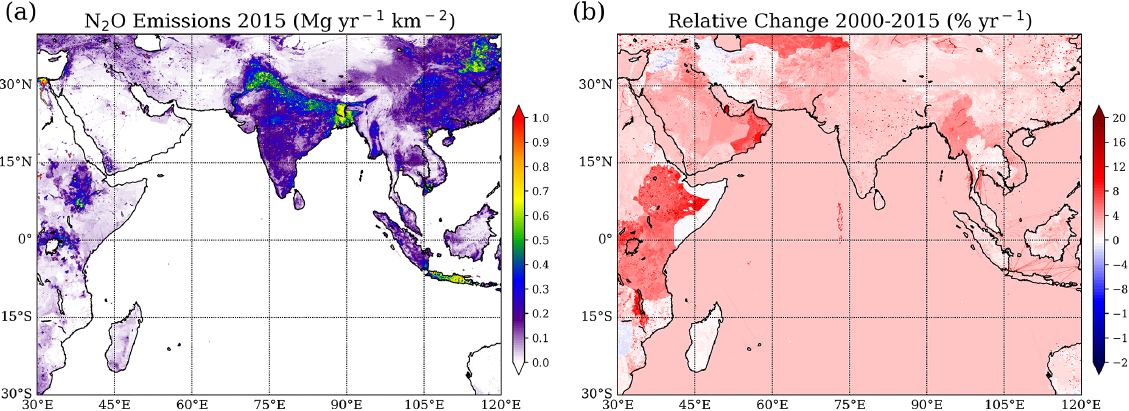
Figure 6. Annual mean N 2 O emissions for 2015 (a) and relative change with respect to 2000 (b) from EDGAR V5.0_GHG.